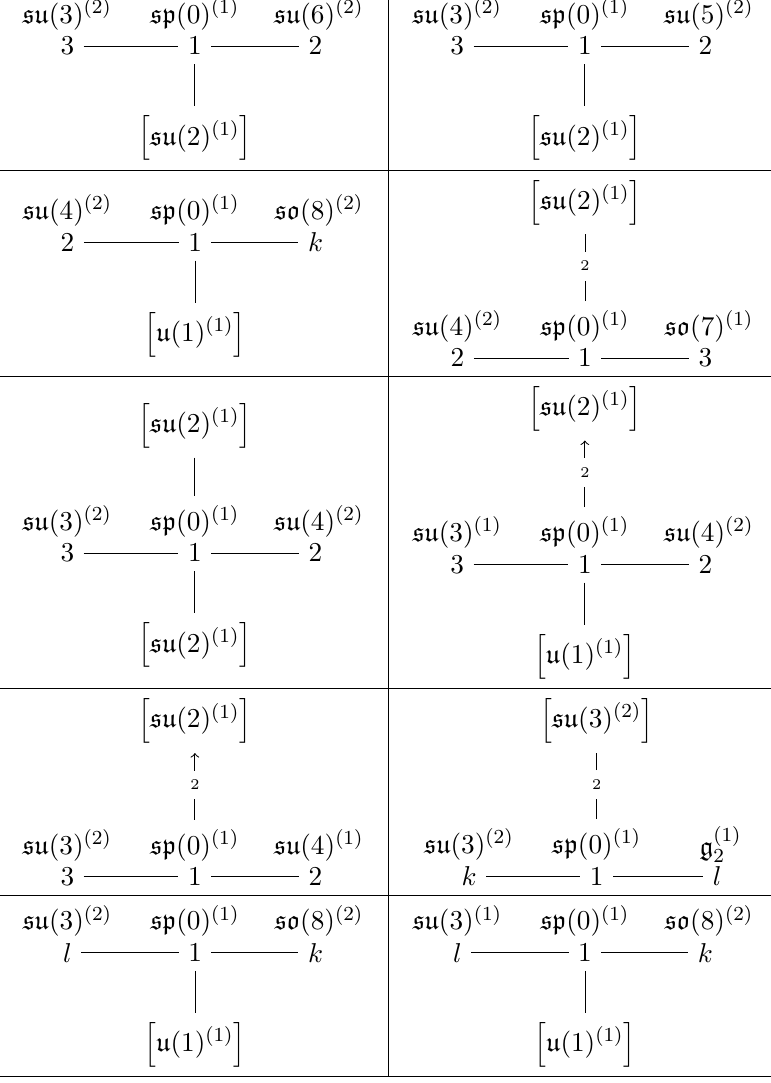
Table 9 . Continued from table 8: possible localized flavor symmetries in 5 d KK theories for nodes with a trivial gauge algebra having no incoming directed edges. Continued in table